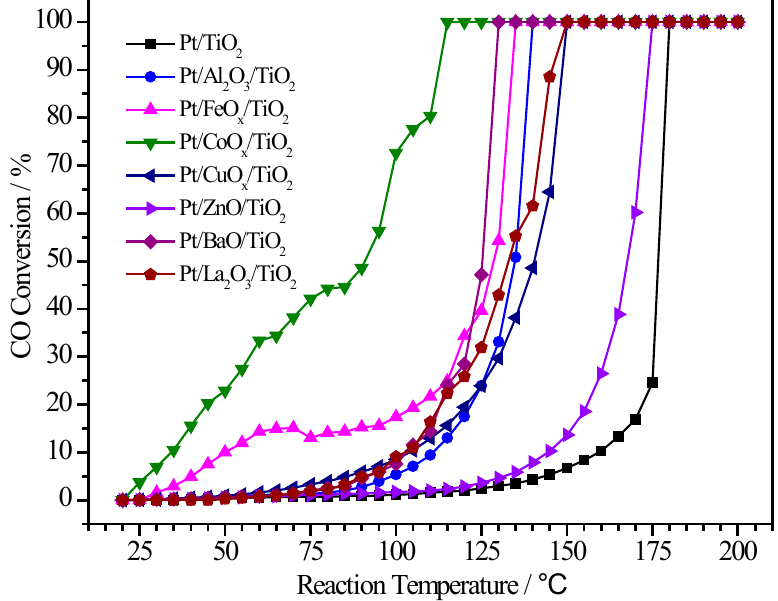
Figure 3. CO conversions on Pt/MO x /TiO 2 catalysts as a function of reaction temperature.